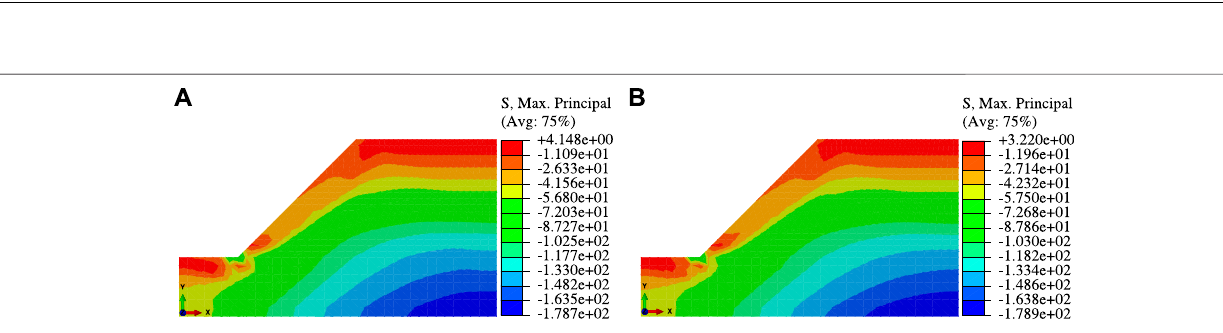
Frontiers in Earth Science |